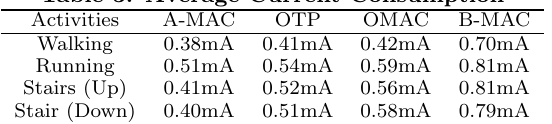
Table 3: Average Current Consumption Activities